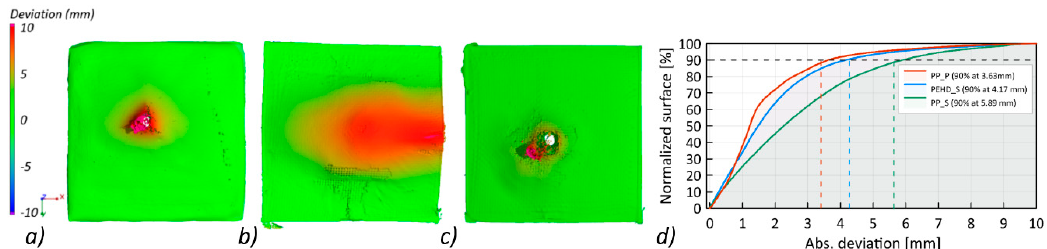
Figure 15. Comparison of surface deformation in the form of a color map after tests: ( a ) PEHD_S, ( b ) PP_S, ( c ) PP_P, and ( d ) cumulative histogram of surface deformation after ballistic impact for the tests.